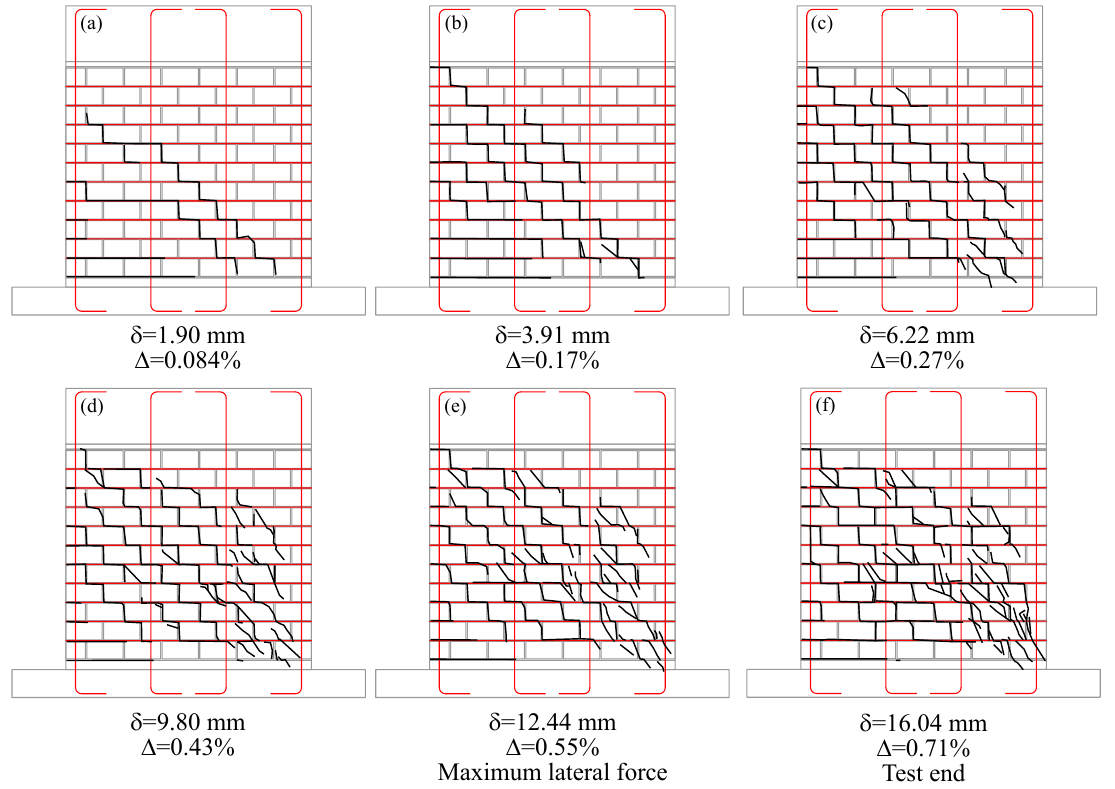
Figure 8. Damage on the wall HCBW1-A at different lateral displacement levels: ( a ) 1.90 mm, ( b ) 3.91 mm, ( c ) 6.22 mm, ( d ) 9.80 mm, ( e ) 12.44 mm, and ( f ) 16.04